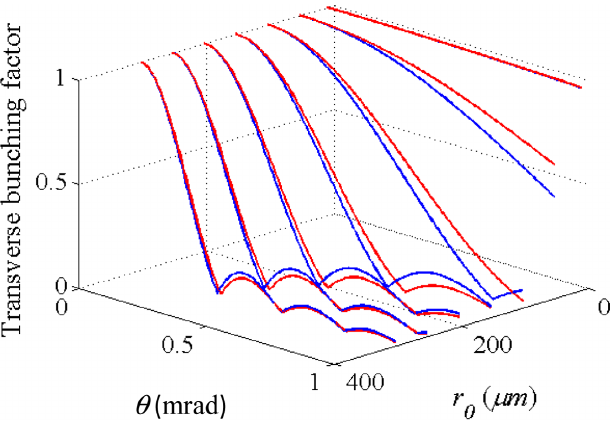
FIG. 10. Angular spectra of the transverse bunching factors of the hollow (red curves) and the solid (blue curves) beams with r 10 , 50, 100, 150, 200, 250 and 300 μ m. With the solenoid 0 ¼ field in our beam line, the beam radius varies along z . In this plot, the particle distributions of the hollow beam with r 0 ¼ 300 , 250, 200, 150, 100, 50 and 10 μ m are obtained at z ¼ 50 . 88 , 48.96, 47.04, 45.12, 43.20, 41.28, 39.36 m, respectively, from the simulation of the considered beam